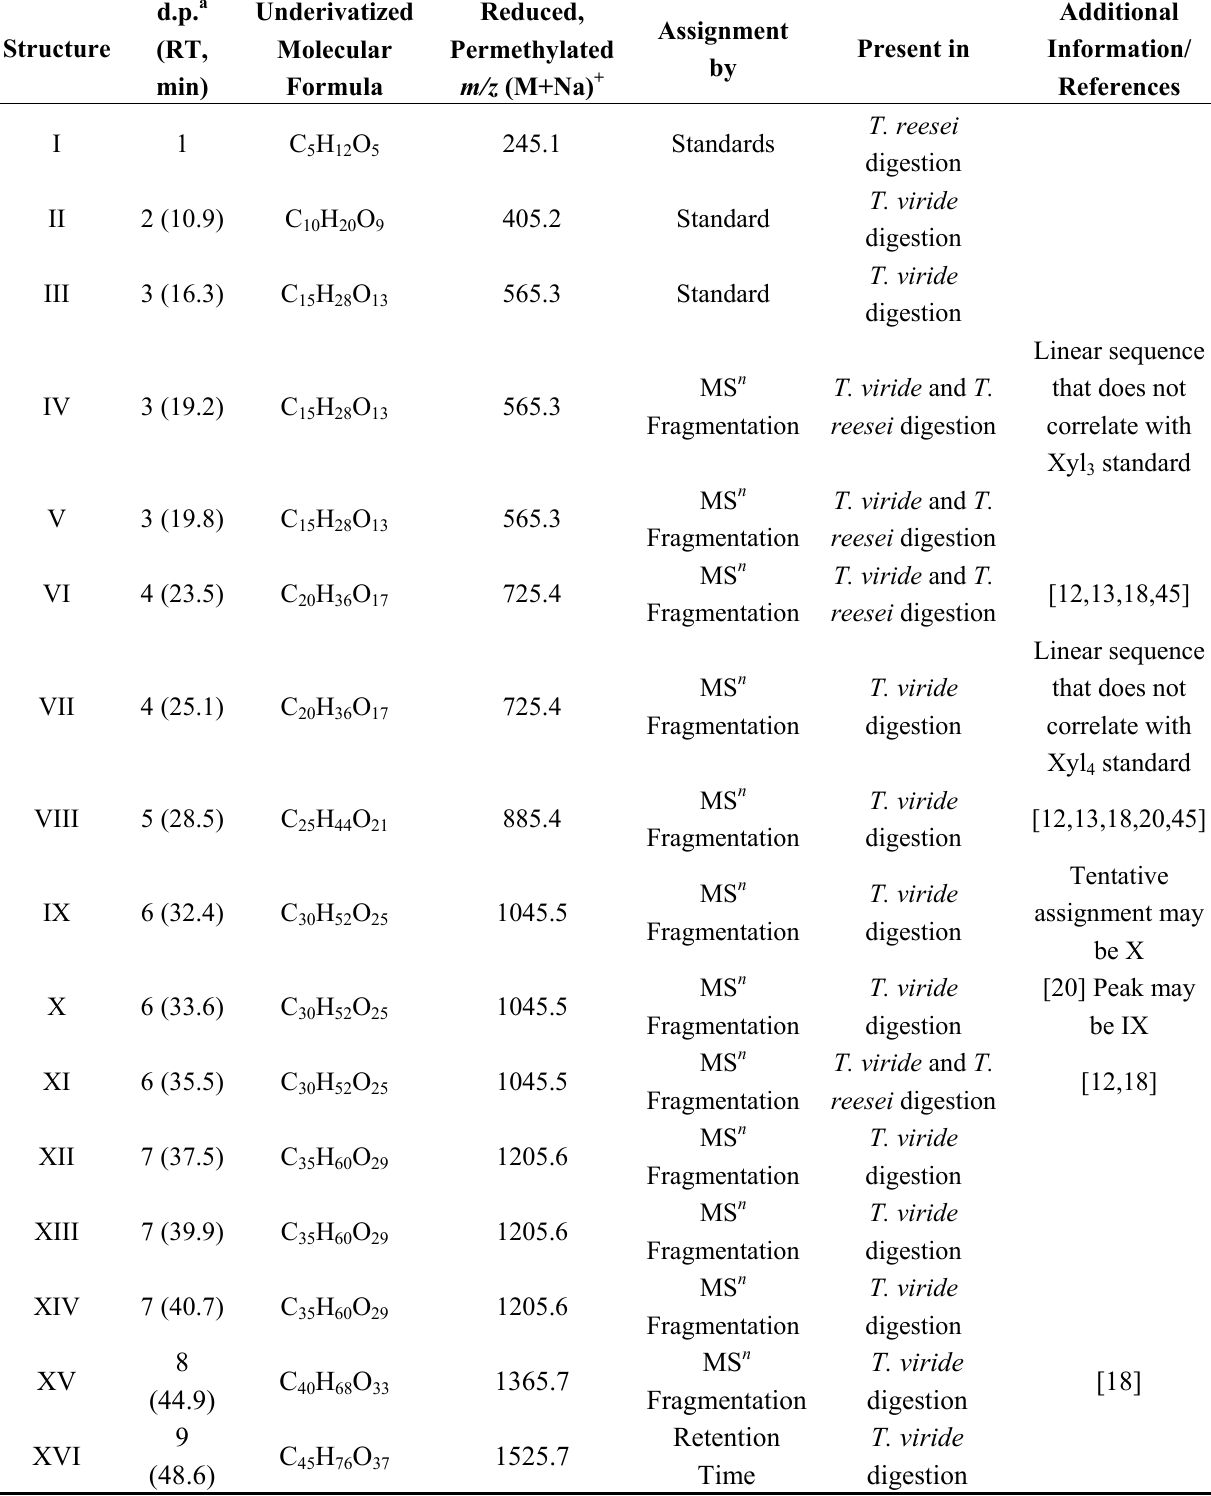
Table 1. Characteristics of Pentose Oligomers analyzed in this study.